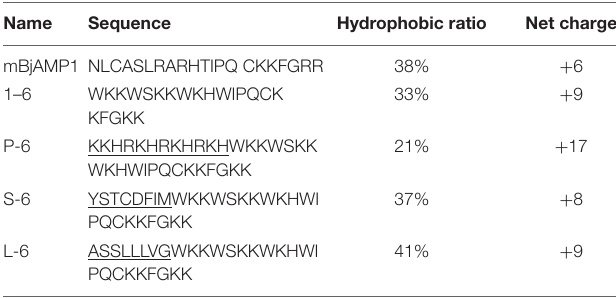
TABLE 1 | Amino acid sequences and chemical properties of all antimicrobial